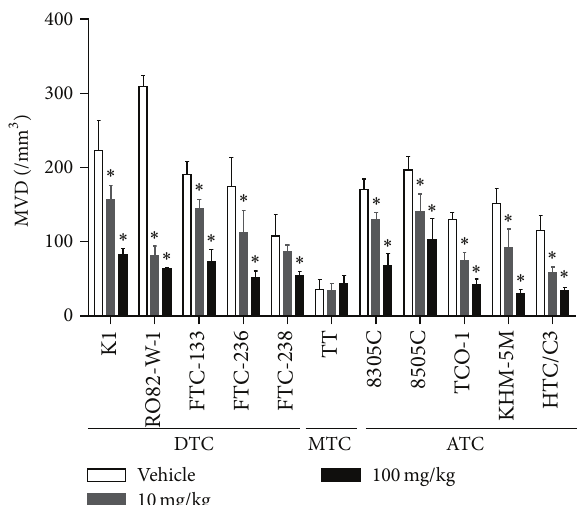
Figure 2: Antiangiogenesis activity of lenvatinib in human thyroid cancer xenograft models in nude mice. Nude mice bearing tumor xenografts were treated orally once daily with either vehicle or lenvatinib at the indicated doses when tumor volumes reached between 100 and 300 mm 3 (day 1). Microvessel density (MVD) was analyzed by immunohistochemical staining of endothelial cells with an anti-mouse CD31 antibody within the resected tumor xenografts as described in Section 2. MVD is expressed as the average number of microvessels per mm 2 in 5 regions of interest (ROIs). Each group consisted of 5 mice. Data are shown as means ± SD. ∗ 𝑃 < 0.05 compared with vehicle-treated mice. DTC: differentiated thyroid cancer, MTC: medullary thyroid cancer, and ATC: anaplastic thyroid cancer.